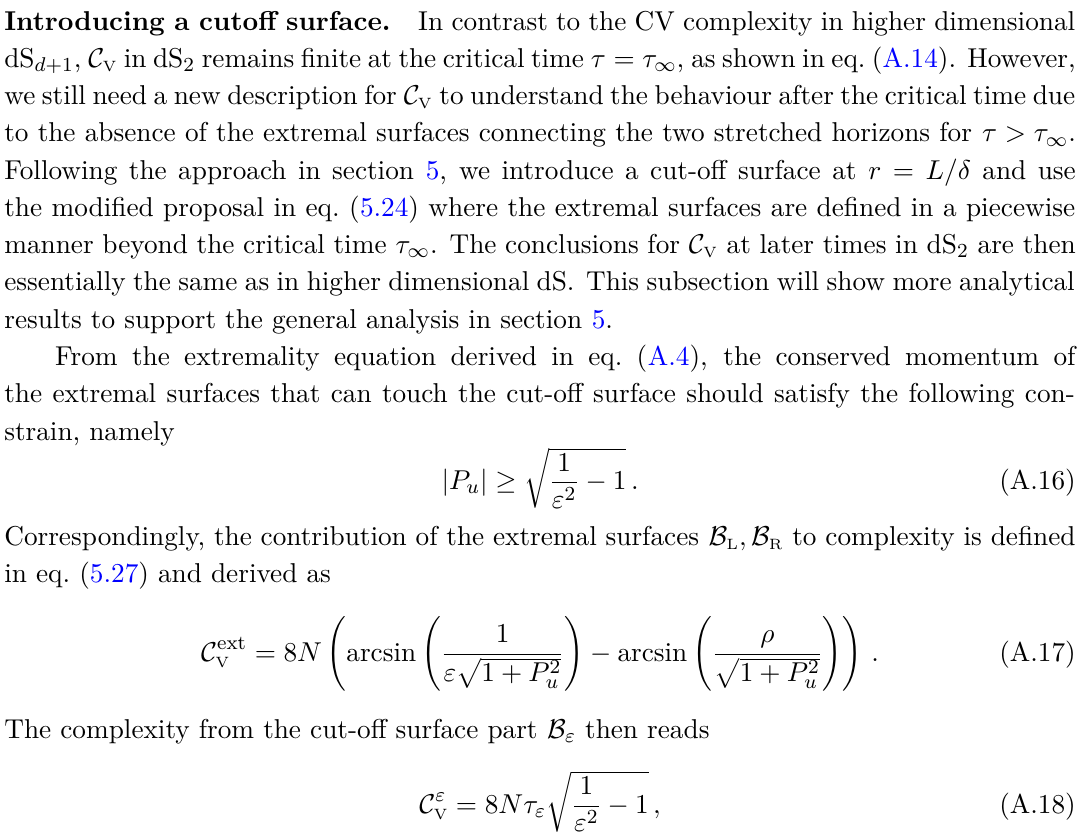
Figure 16 . Left: time evolution of holographic complexity C growth rate of complexity in dS 2 . The black line indicates the growth rate for the linear growth after the transition time τ crt